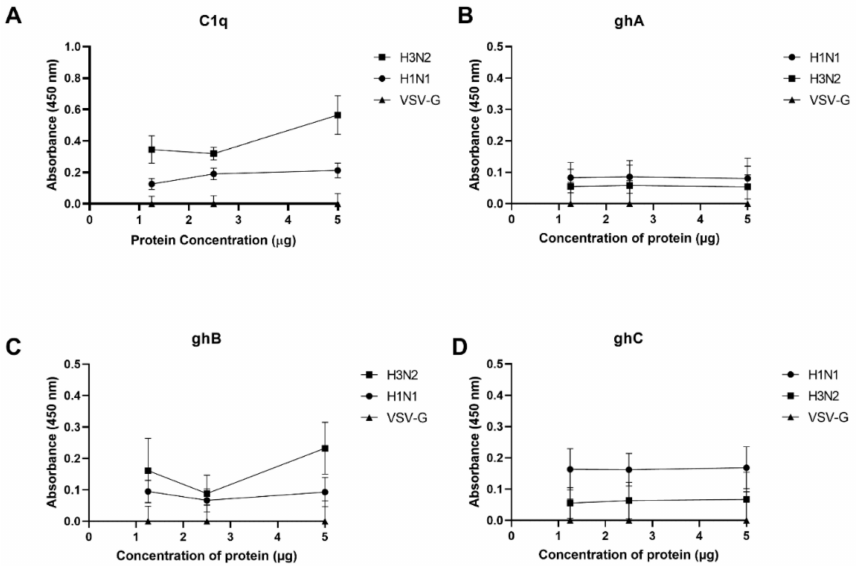
Figure 1. Interaction of H1N1 and H3N2 subtypes of influenza A virus (IAV) with C1q ( A ), ghA ( B ), ghB ( C ) and ghC ( D ). Decreasing concentrations (5, 2.5, and 1.25 µ g) of human C1q and its recombinant globular head modules were coated overnight in a 96-microtiter well plate in carbon- ate/bicarbonate (CBC) buffer, pH 9.6 at 4 ◦ C. Next, the wells were washed three times with PBS. Then, 20 µ L of H1N1 or H3N2 virus (1.36 × 10 6 pfu/mL) was added to corresponding wells and incubated at 37 ◦ C for 2 h. After removing and washing off the unbound viruses, the wells were probed with primary antibodies (100 µ L/well): monoclonal anti-influenza virus H1 or anti-influenza virus H3 (1:5000) antibodies, respectively. VSV-G pseudo-typed lentivirus was used as a negative control. The data were expressed as the mean of three independent experiments carried out in triplicate ± SD. The background was subtracted from all samples. In addition, the absorbance of Maltose Binding Protein (MBP) (5, 2.5, and 1.25 µ g) was subtracted from the respective absorbance of the recombinant MBP tagged globular head modules ( B – D